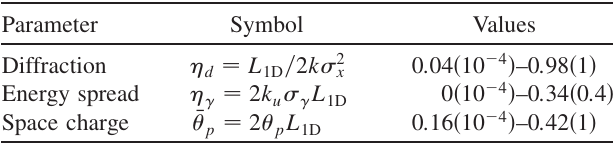
TABLE I. Scan parameters. Simulations (theory). Parameter Symbol Values Diffraction